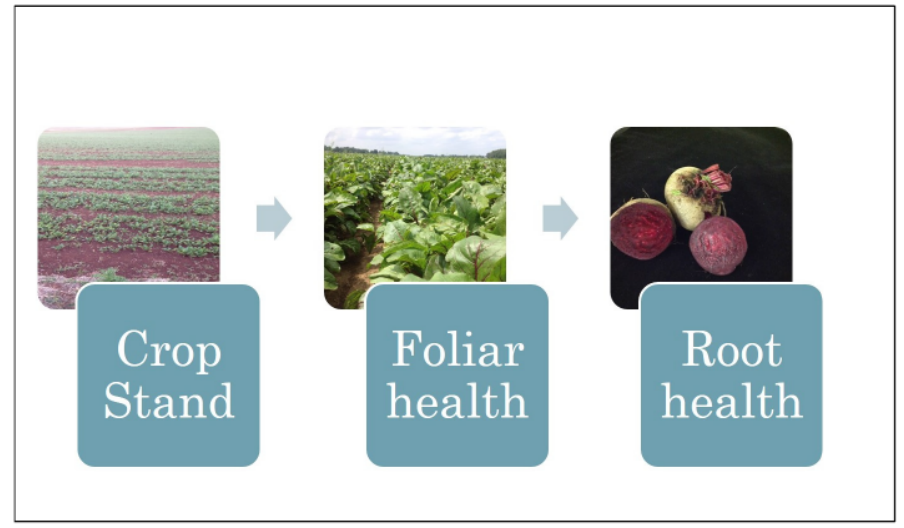
Figure 2. Critical points in the cultivation of table beet in New York at which plant diseases may significantly affect root yield and quality. Table 1. Diseases affecting table beet production in New York including dominant current management strategies and control tactics.